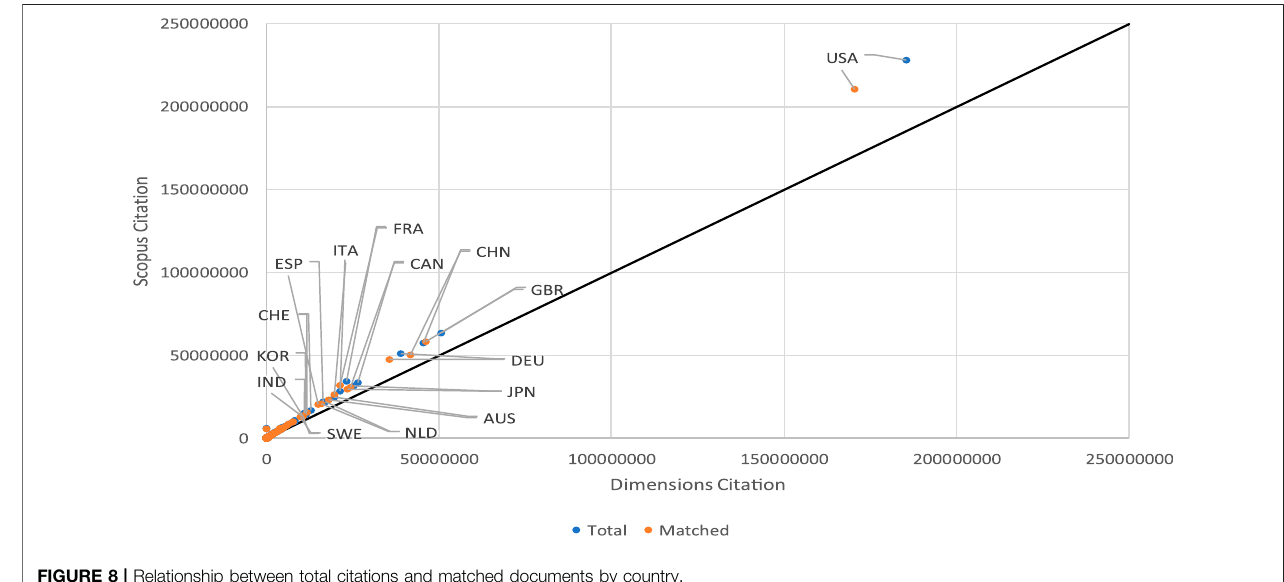
FIGURE 8 | Relationship between total citations and matched documents by country.